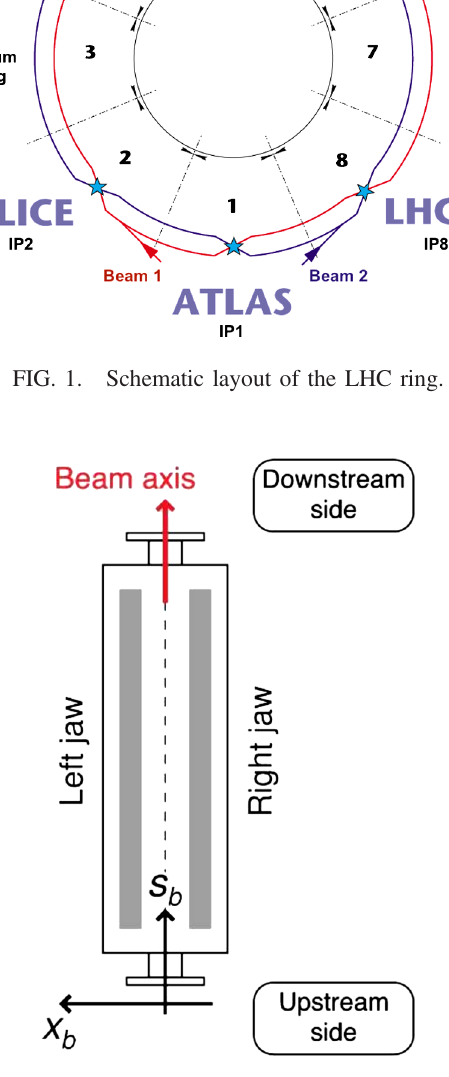
FIG. 2. Collimator coordinate system, as viewed from above [8].